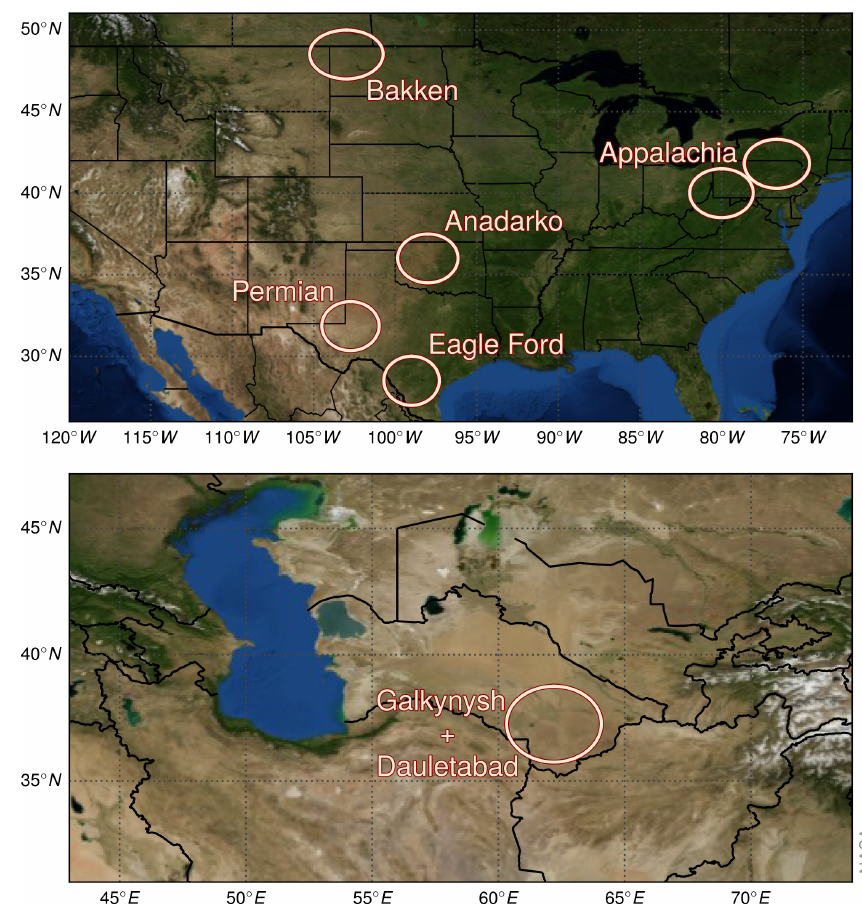
Figure 1. Location of the analysed natural gas and oil production regions. Due to its large and elongated extent, the Appalachia region is split into two subregions. All circles have a radius of 166 . 5km, corresponding to 1 . 5 ◦ after the coordinate transformation described in Sect.